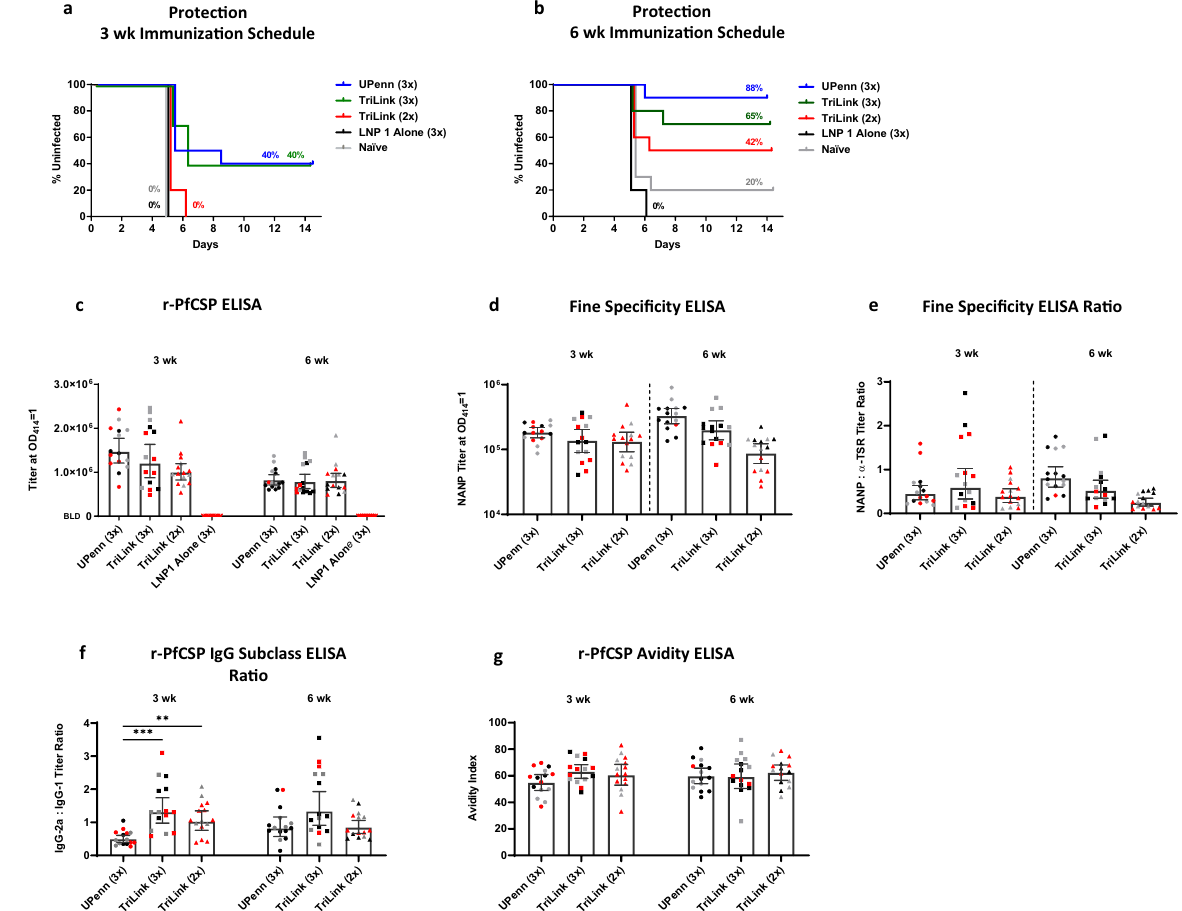
Fig. 3 PfCSP mRNA-LNP1 induced responses in BALB/c. A 10 μ g dose of PfCSP mRNA, TriLink and UPenn, prime:boost (2x) or prime:boost: boost (3x) regimen at a 3 week or 6 week interval was tested in a Pb(ANKA)-PfCSP (NF54/3D7) transgenic challenge model ( N = 10 for all groups except LNP1 Alone, N = 5) with 1000 sporozoites injected intravenously, two weeks post fi nal immunization. a – b Kaplan – Meier curves depict the percent survival of challenged mice with a 3 week and b 6 week immunization schedules and are extrapolated from the negative controls ’ (LNP1 Alone and Naïve) survival percentage. Survival was de fi ned as mice without detectable parasitemia by thin blood smear. PfCSP antibody responses were determined by c r-PfCSP ELISA, d fi ne speci fi city ELISA against the (NANP)6 repeat peptide, e the ratio of the (NANP)6 titer to the α -TSR titer, f the ratio of r-PfCSP IgG subclass titers for IgG2a and IgG1, and g r-PfCSP avidity ELISA ( N = 15 UPenn 3x, TriLink 3x, TriLink 2x) ( N = 8 LNP1 Alone). Uninfected, infected, and unchallenged mice are represented by black, red, and gray symbols, respectively. Data in the bar graphs are reported as the GM with 95% CI. All statistical analyses were performed using one-way ANOVA on ranks, Kruskal- Wallis post hoc Dunn ’ s multiple comparison test (** = p < 0.01; *** = p <